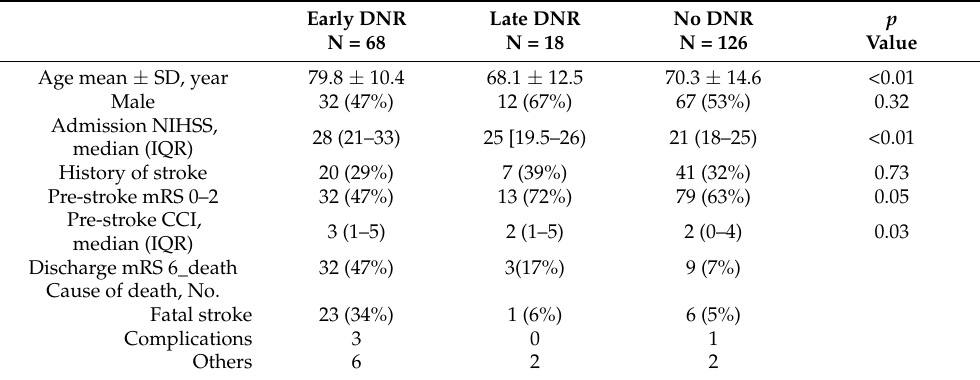
Table 3. Clinical characteristics * in 212 patients with severe acute ischemic stroke classified by DNR